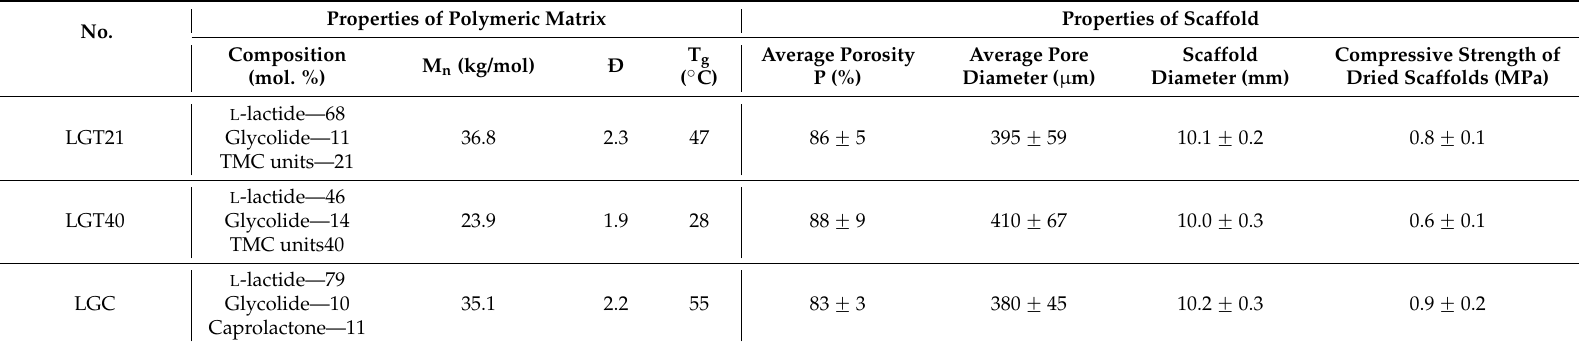
Table 1. Properties of investigated scaffolds and used polymeric matrices.